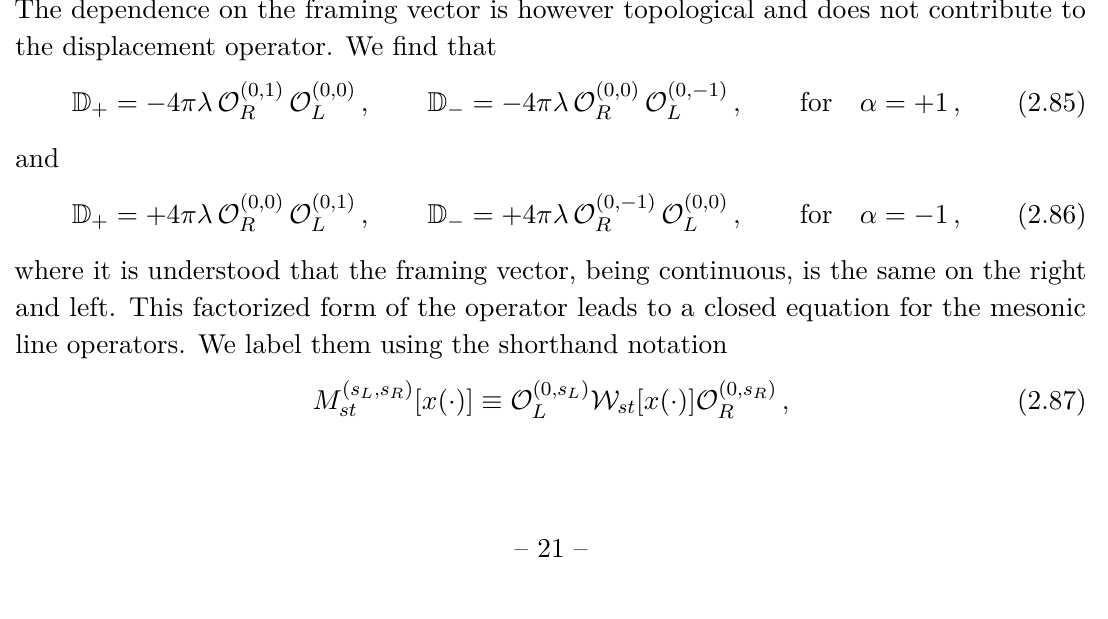
from the right. For instance, { ∂ L